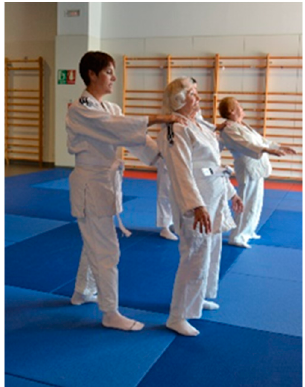
Figure 9. Unbalance movements.